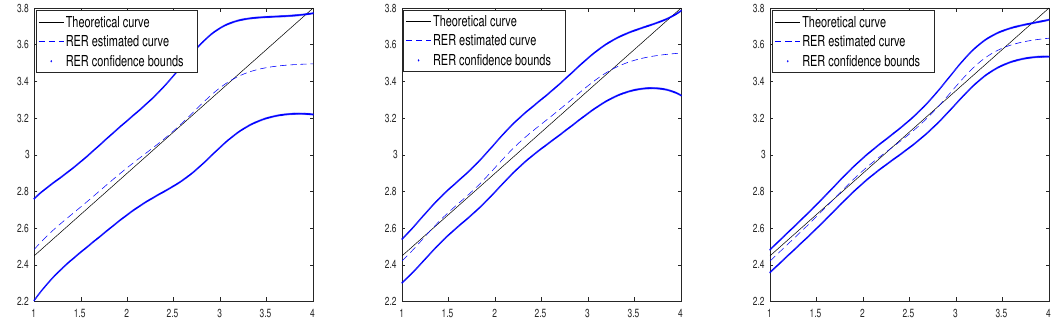
Figure 9: ρ 1 = 0.9 with CR ≈ 25% and n = 50, 200 and 400